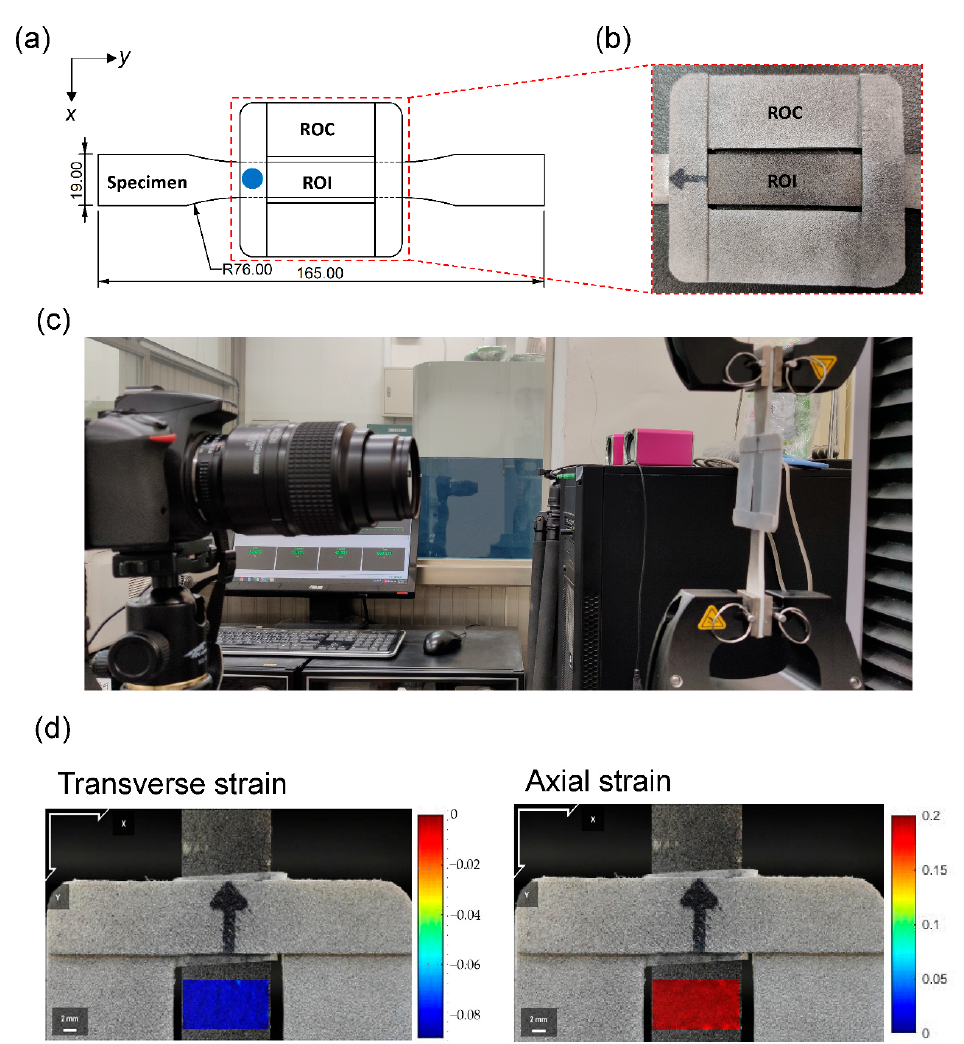
Figure 1. ( a ) Dimensions of the specimen (ASTM D638), the ROI, and the ROC. The blue dot indi- cates the attachment location. ( b ) A close-up image near the ROC and the ROI. ( c ) Experimental setup of the cyclic test. ( d ) Representative Green strain fields measured by DIC at a stretch ratio of 1.186. ROI: region of interest; ROC: region of compensation. region of interest; ROC: region of